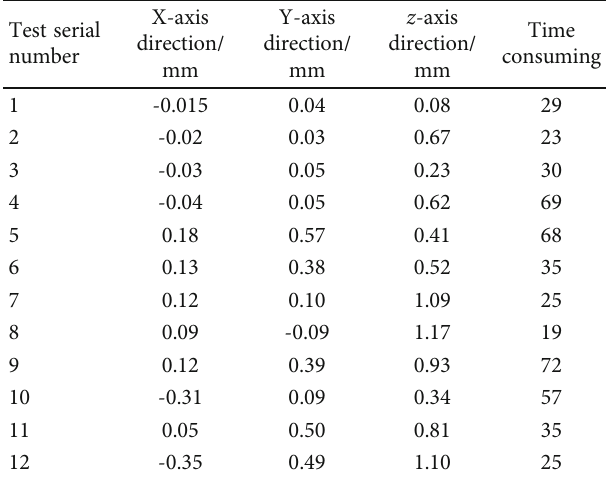
Table 5: Experiment record